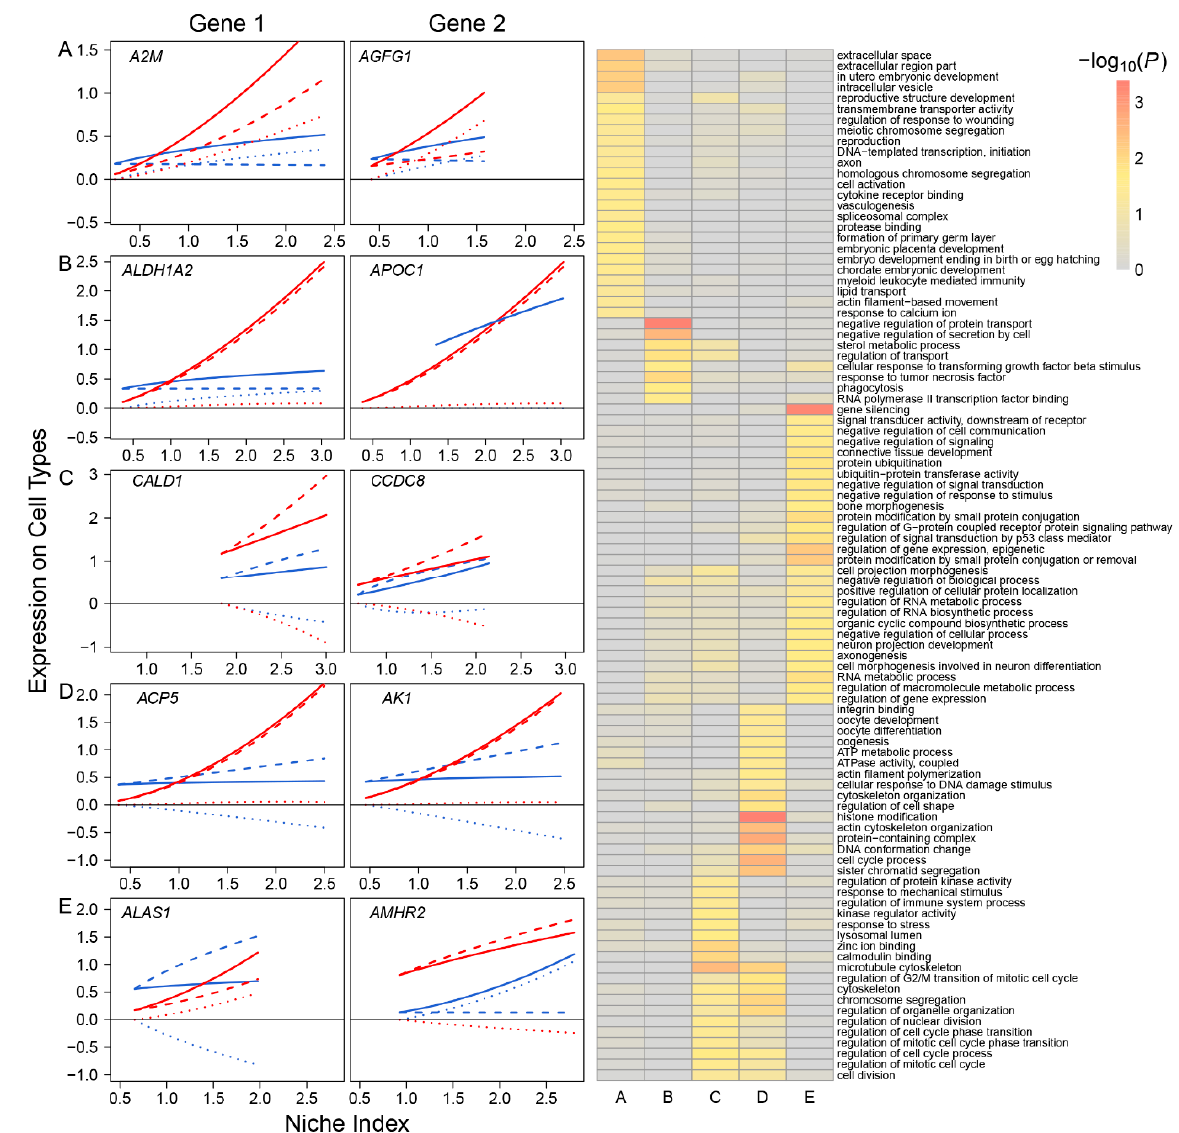
Figure 2. Five different types of FGC–soma interactions driven by genes. Left panel : The NI-varying change of each interaction type, illustrated by two representative genes. ( A ) Synergism—FGCs and the somas activate each other, driven by 785 genes. ( B ) Directional synergism—one cell type activates the other whereas the second has no impact on the first, driven by 82 genes. ( C ) Antagonism—both cell types inhibit each other, driven by 52 genes. ( D ) Directional antagonism—one cell type inhibits the other whereas the second has no impact on the first, driven by 87 genes. ( E ) Altruism/exploitation— one cell type activates (or inhibits) the other but the second reversely inhibits (or activates) the first, driven by 214 genes. For each interaction type, solid, slashed, and dotted lines denote the overall expression profile, independent expression component profile, and dependent expression component profile of each cell type, FGCs (blue) and somas (red). Right panel : GO analysis of genes that drive various types of interactions ( A – E